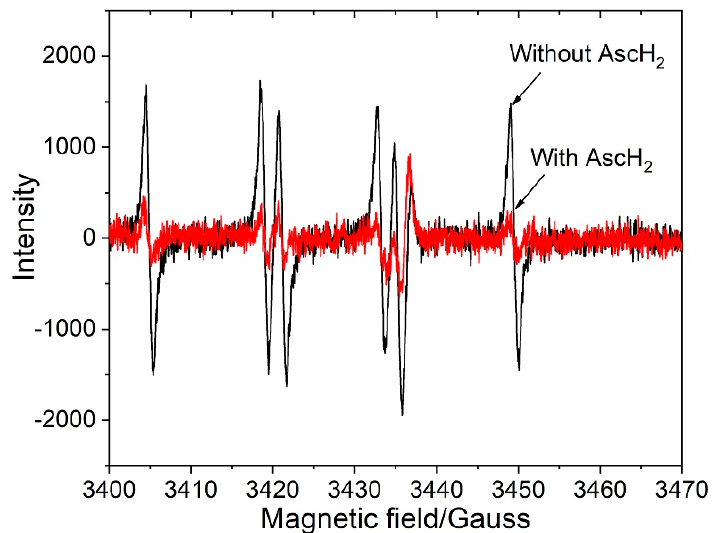
Figure 5. EPR spectra of TMIO–OH spin adduct in the absence (black) and presence (red) of 100 mM ascorbic acid in the presence of 6 mM L1. Reaction mixture: 20 mM TMIO; 3 mM FeCl 3 ; 12 mM H 2 O 2 ; pH = 3.0.